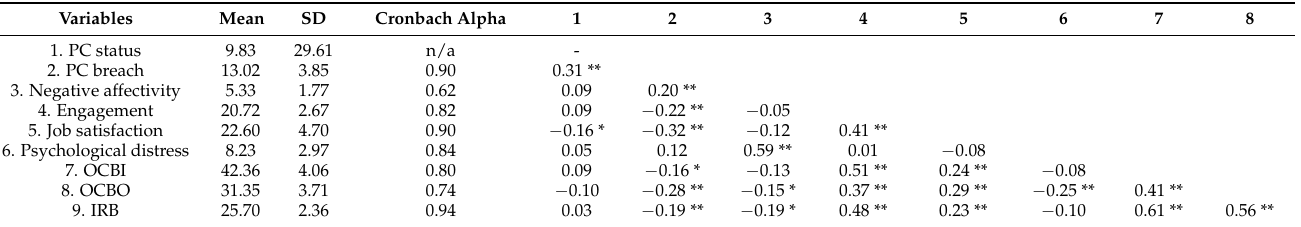
Table 1. The descriptive statistics for all of the predictor and outcome variables later used in the SEM 1